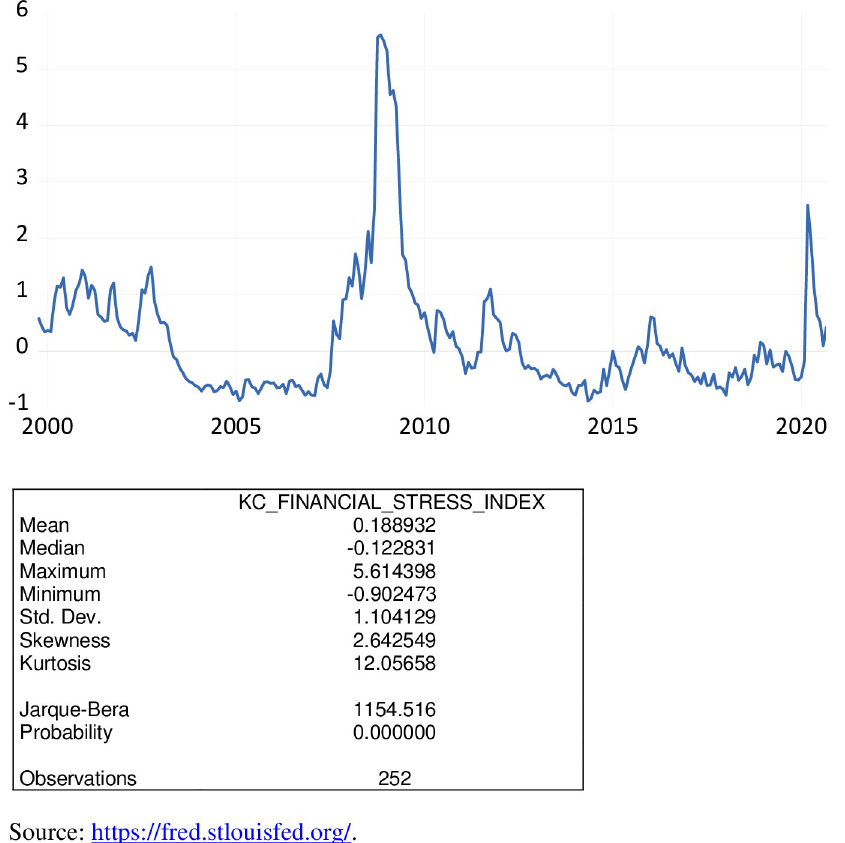
Fig 7. The Kansas City finanical stress index, October 1999 to September